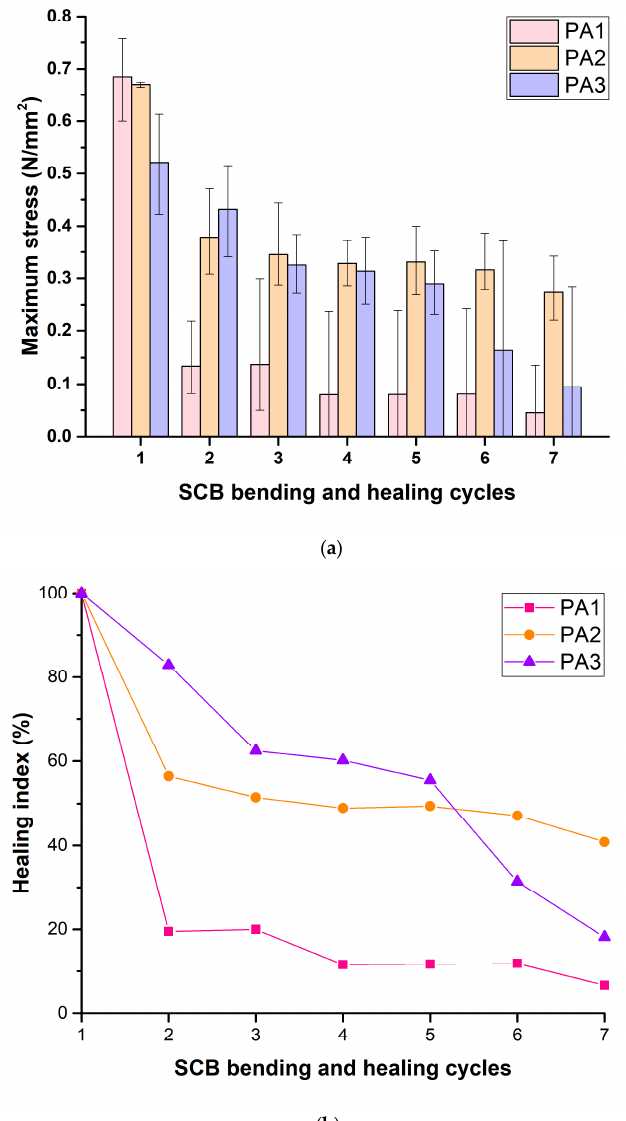
Figure 6. The development of fracture resistance of SCB specimens during the bending and heal-